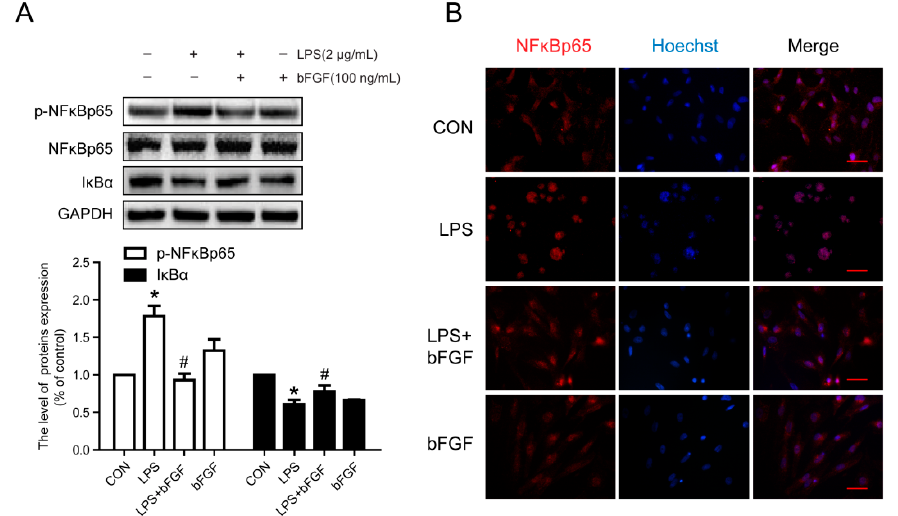
Figure 7. Effect of bFGF on activation of NF κ B in LPS-stimulated astrocytes. Cells were incubated in the presence of LPS (2 µg/mL) with or without bFGF (100 ng/mL) for 24 h. ( A ) Western blot of p -NF κ Bp65, NF κ Bp65 and I κ B and densitometric analyses; ( B ) Immunofluorescence of NF κ Bp65 (red), the nuclear is labeled by Hoechst (blue). * p < 0.05 versus CON, # p < 0.05 versus LPS. All results represent at least three independent experiments. Scale bar is 50 µm.